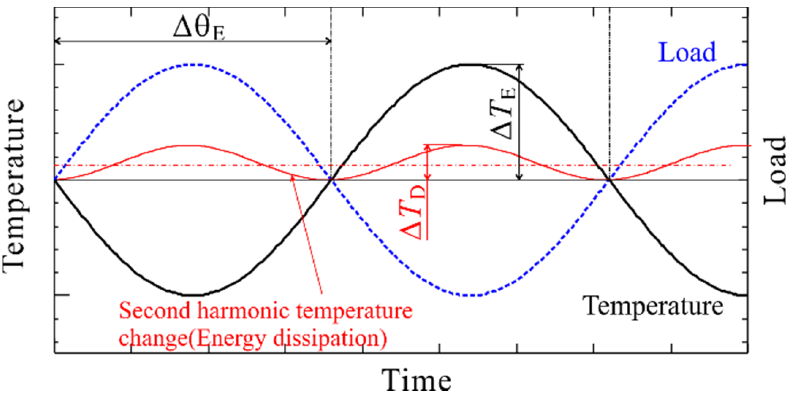
Figure 1. Schematic illustration of thermoelastic temperature change and phase of thermal signal.